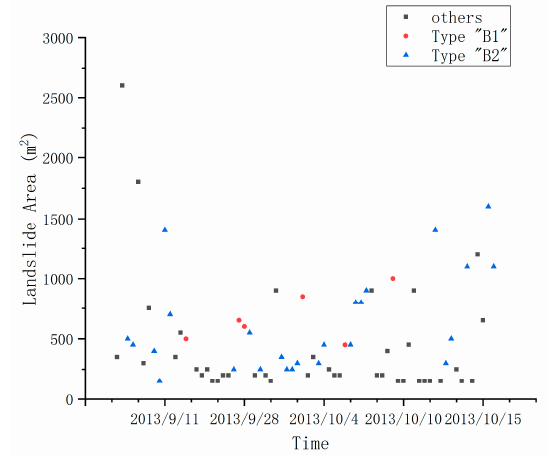
Figure 6. Position of the sliding surface. The 72 landslides records can be divided into two types according to the position of the sliding surface as A and B. Examples of the two types of landslide surfaces are shown on the right.